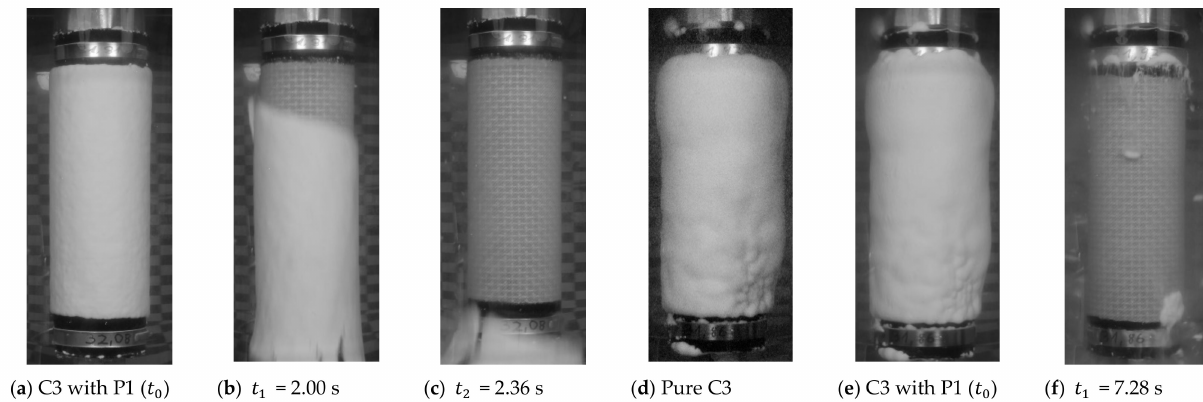
Figure 10. Regeneration of C1 and P1 with 0 13 kg · m − 2 each for a new filter ( a – c ) and a regeneration of C1 (1.07 kg · m − 2 ) with P1 (2.13 kg · m − 2 ) for a dirty filter ( d – f